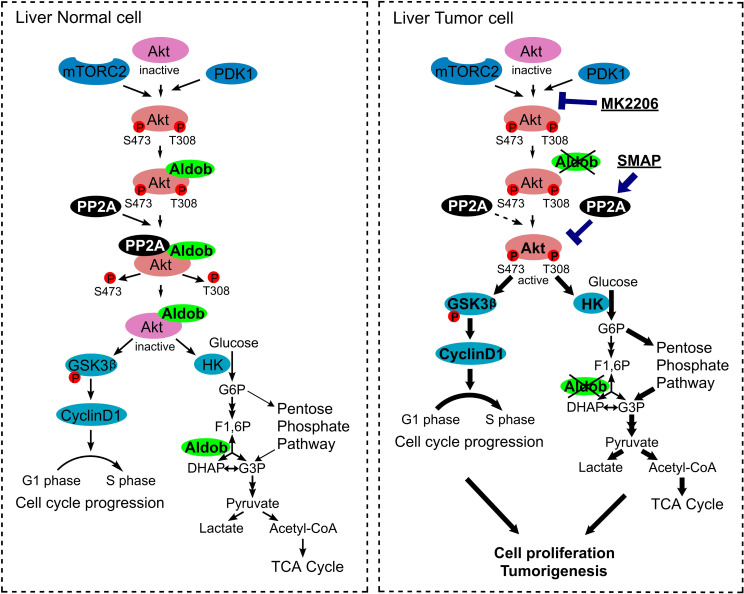
A schematic model of Aldob-mediated negative regulation of Akt activation.In normal cells, Aldob interacts with Akt in an Akt kinase activity-dependent manner, which promotes phosphatase PP2A binding to p-Akt and results in p-Akt dephosphorylation. Aldob is involved in the intracellular homeostasis of Akt phosphorylation through modulating substrate/phosphatase interactions. In Aldob-deficient cancer cells, down-regulation of Aldob releases its negative regulation of Akt activity, leading to constitutive activation of oncogenic Akt signaling, which facilitates cell cycle progression and increases glucose consumption and metabolic flux to glycolysis and TCA cycle for cancer cell proliferation and tumorigenesis. Targeting hyperactive Akt through directly inhibiting Akt activity or reactivating PP2A phosphatase activity may be a viable therapeutic approach to treat Aldob-deficient human cancers. Bold arrows represent up-regulation of indicated signaling events in response to the absence of Aldob. Aldob, aldolase B; DHAP, dihydroxyacetone phosphate; GSK3ß, glycogen synthase kinase 3ß; HK, hexokinase; mTORC2, mechanistic target of rapamycin complex 2; p-Akt, phosphorylated Akt; PDK1, phosphoinositide-dependent kinase 1; PP2A, protein phosphatase 2A; SMAP, small-molecule activator of PP2A; TCA cycle, tricarboxylic acid cycle.